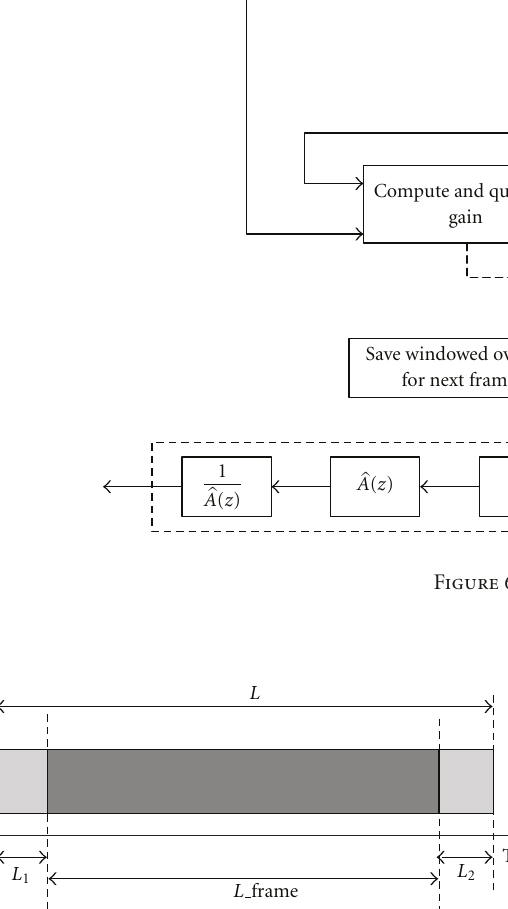
There is no windowing for the overlapping data of previous frame. But for the overlapping data of next frame, a cosine window w ( n ), ( w ( n ) = sin(2 πn/ 4 L 2 ), n = L 2 , L 2 + 1, ... ,2 L 2 − 1) is applied. Because of the overlapping part of the previous frame, if the next frame will be encoded in TCX mode, the length of the window for the header of the next frame should equal to L 2